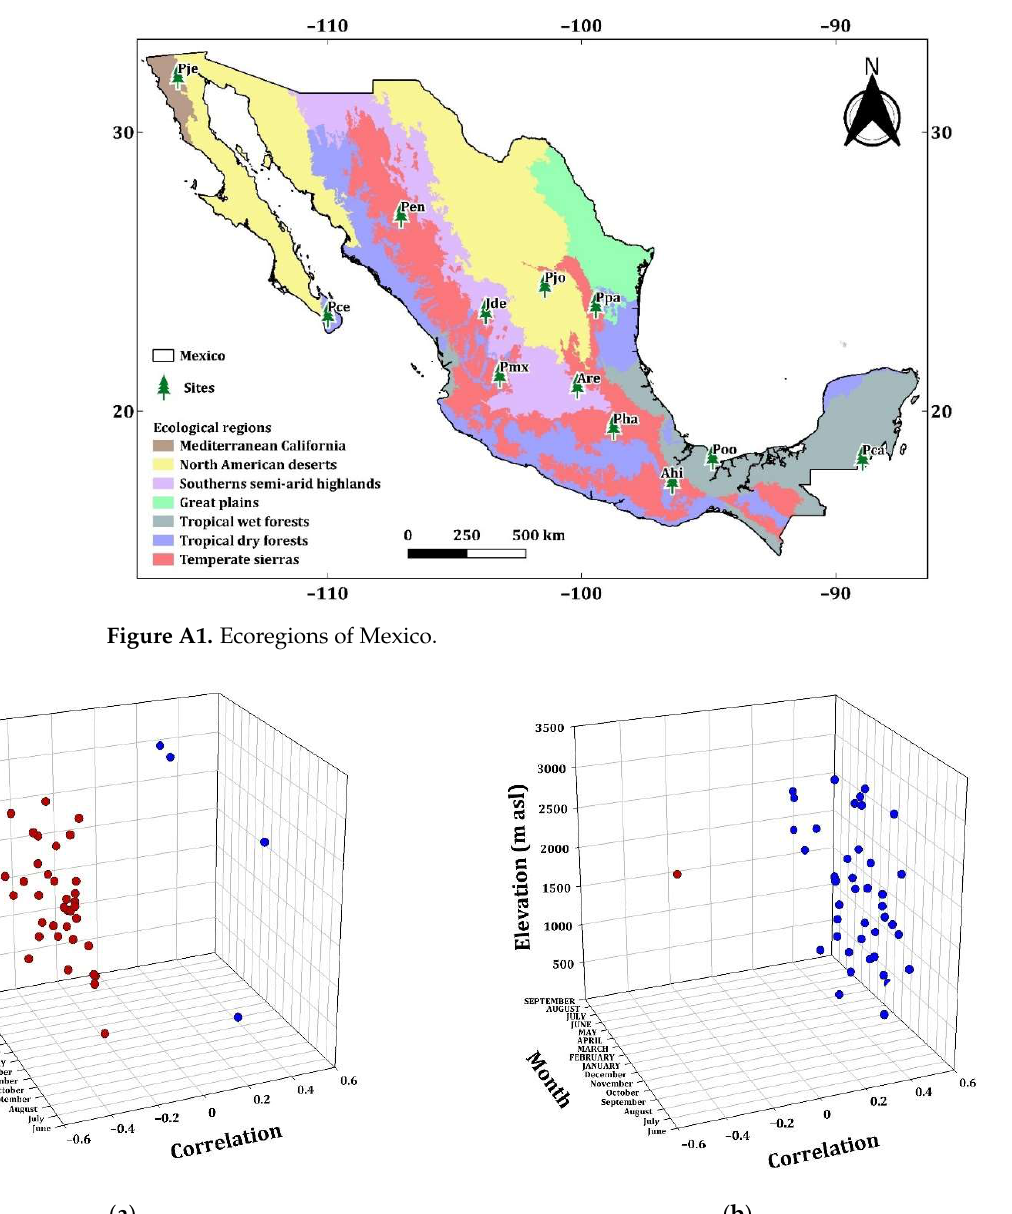
Figure A2. Radial growth–climate associations. Correlation coefficients (Pearson) between TMax ( a ) and PP ( b ), with the RWI of the twelve conifer species as a function of elevation. Significant ( p < 0.05) positive (blue dots) and negative (red dots) correlations among monthly values (from the previous Sep to AUG of the growth year) of TMax and PP and ring width chronologies.